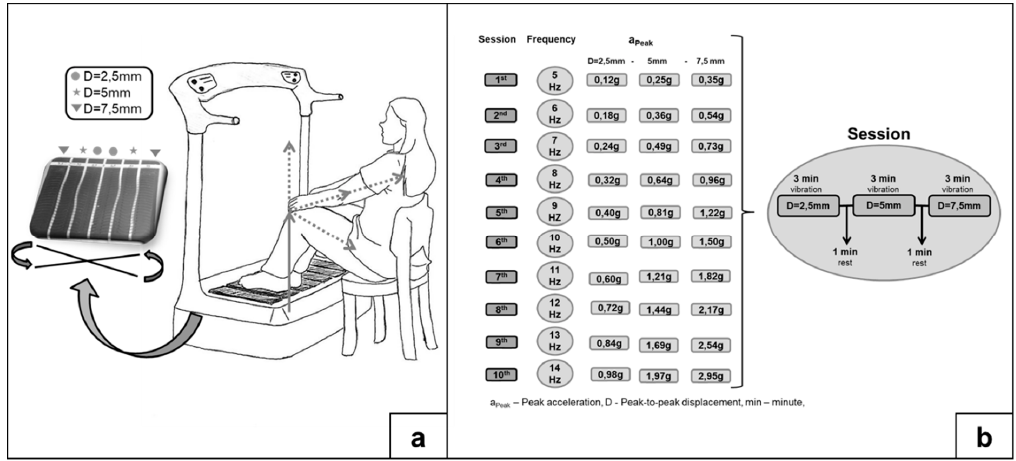
Figure 1. ( a ) The position of participants on the vibrating platform. ( b ) The protocol of the whole-body vibration group (WBVG) intervention.